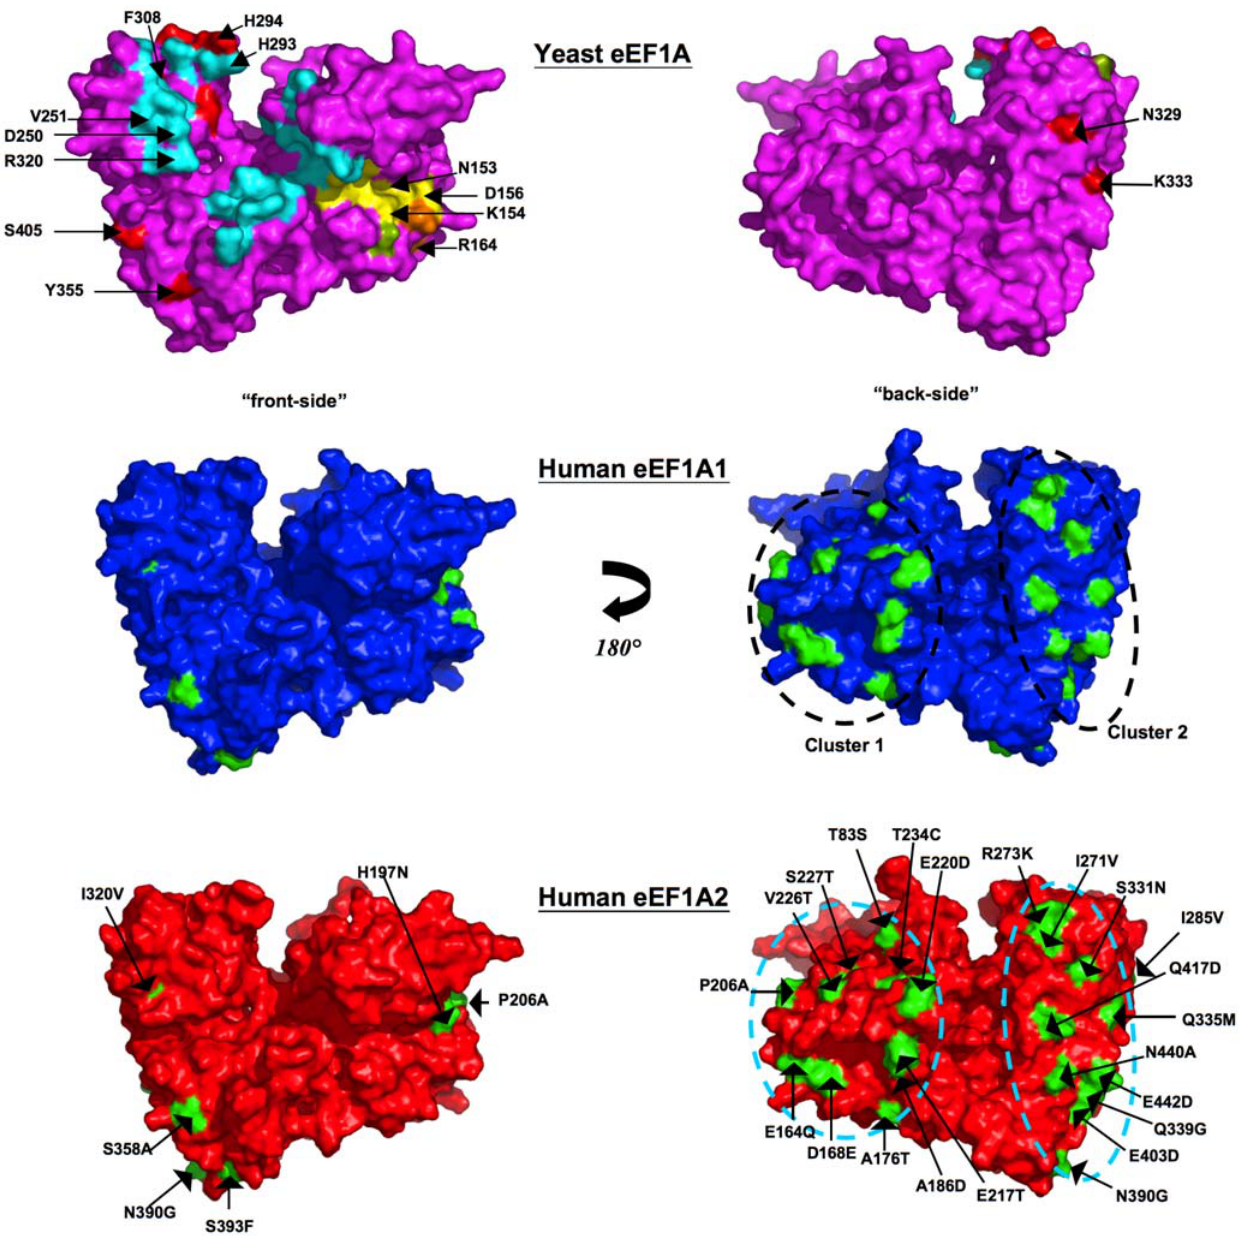
Figure 3. Location of variations in amino acids mapped onto surface. Two equivalent views rotated by 180 u about the y -axis depicting a surface rendition of the yeast eEF1A crystal structure colored magenta (top panel), and the 3-D models of eEF1A1 colored blue (middle panel) and eEF1A2 colored red (bottom panel). Locations of exposed variant side-chains are mapped onto the surface of the two model proteins (colored green) and labeled on the eEF1A2 model - the variant residue from eEF1A1 is shown on the right-hand side of the label. The two sub-clusters are apparent in this representation. The location of the C-terminal eEF1B a -binding site (cyan) [38] and GDP-binding site (yellow) [39] is mapped on the crystal structure. Also highlighted (red) on its surface are: mutations that reduce actin disorganization induced by overexpression of eEF1A, inhibit actin- bundling without altering translation in vivo , and reduce actin-bundling [70,71]. There are no variants in proximity to those residues implicated on the basis of mutagenesis to be involved in translational fidelity (green) [77]. However, two variant positions in humans - Gln164Glu and Glu168Asp are in close proximity to Arg166 – a conservative mutation for the equivalent residue in yeast (Arg164Lys) was shown to reduce dependence on eEF1B (orange) [78,79]. Gln164Glu and Glu168Asp, however, both retain their main-chain to main-chain H-bonds with Arg166. Note: for clarity the three proposed aminoacyl-tRNA-binding residues [38] are not shown, since they overlap with already highlighted positions implicated in binding eEF1B a (His293 and Arg320) and actin (His294). subunits [67]. One explanation for the negative yeast-two-hybrid stabilized by direct contacts at these sites of variation. Moreover, it results is that the N-terminal segment of eEF1B a ( . 100 amino is known that eEF1A1 also interacts with eEF1B D [6]; eEF1B D acid residues) - which was not present in the yeast crystal structure shows sequence similarity to eEF1B a , and can also function as a - wraps around and contacts the ‘‘far-side’’ of eEF1A1 [6], GEF [7]. Clearly, further experiments assessing binding between